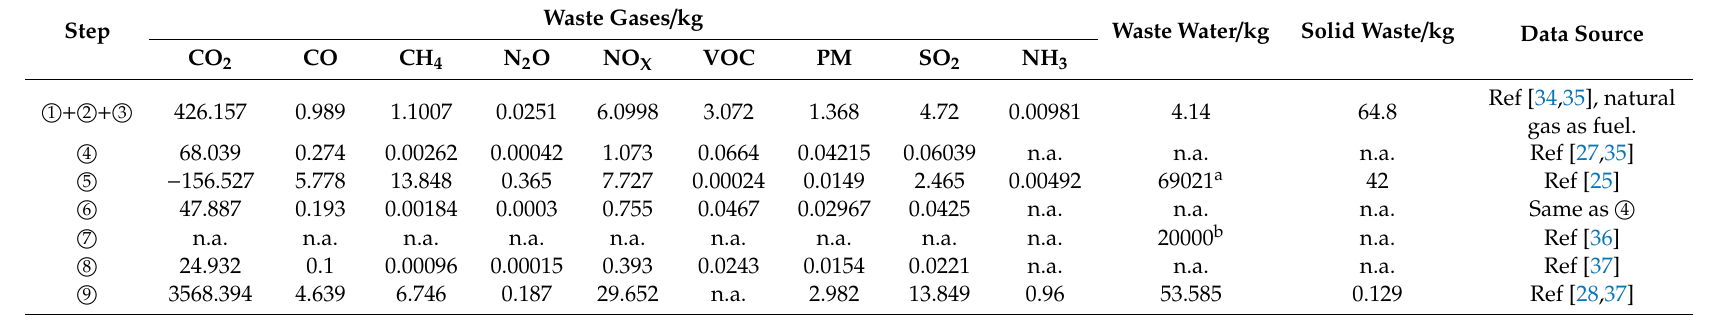
Table 1. Cradle-to-gate inventory of the PLA-based